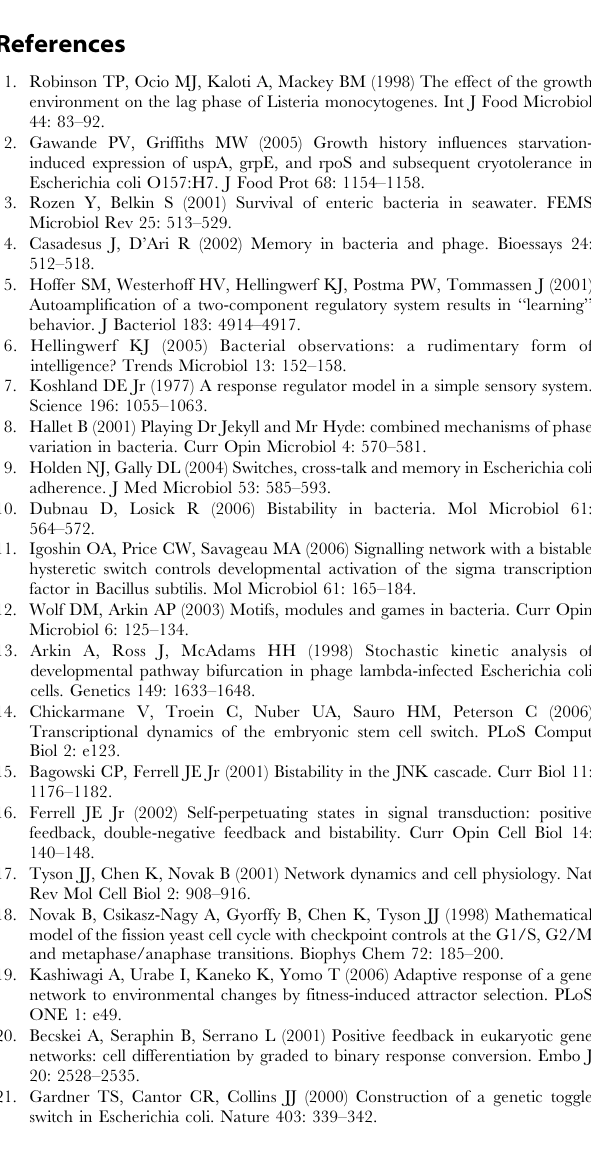
Figure S3 The P spoIIE-gfp fusion activity tracks spoIIE gene